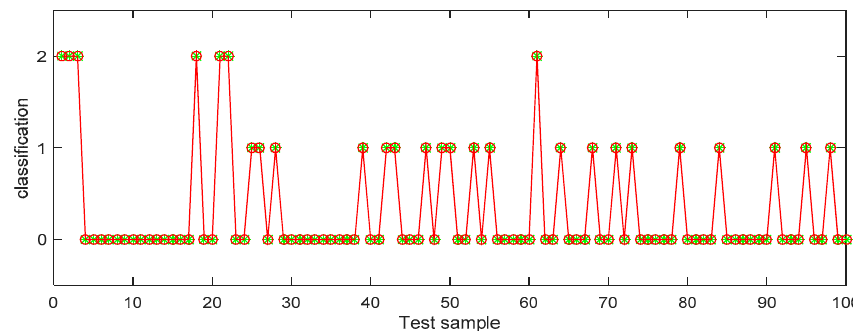
Figure 9. Random forest identification results from dataset 2.